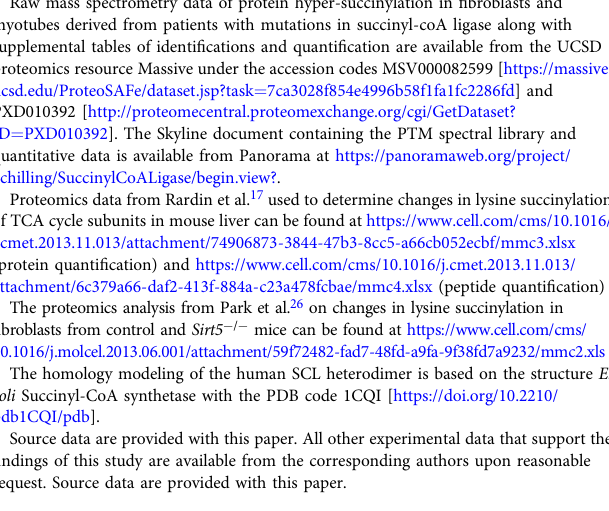
Protein structure modeling . Structural modeling was performed using SWISS- Model Server and multiple sequence alignment using PROMALS3D Server. Model and Figure preparations were done with Discovery Studio v4.1 (Accelrys) as reported 24